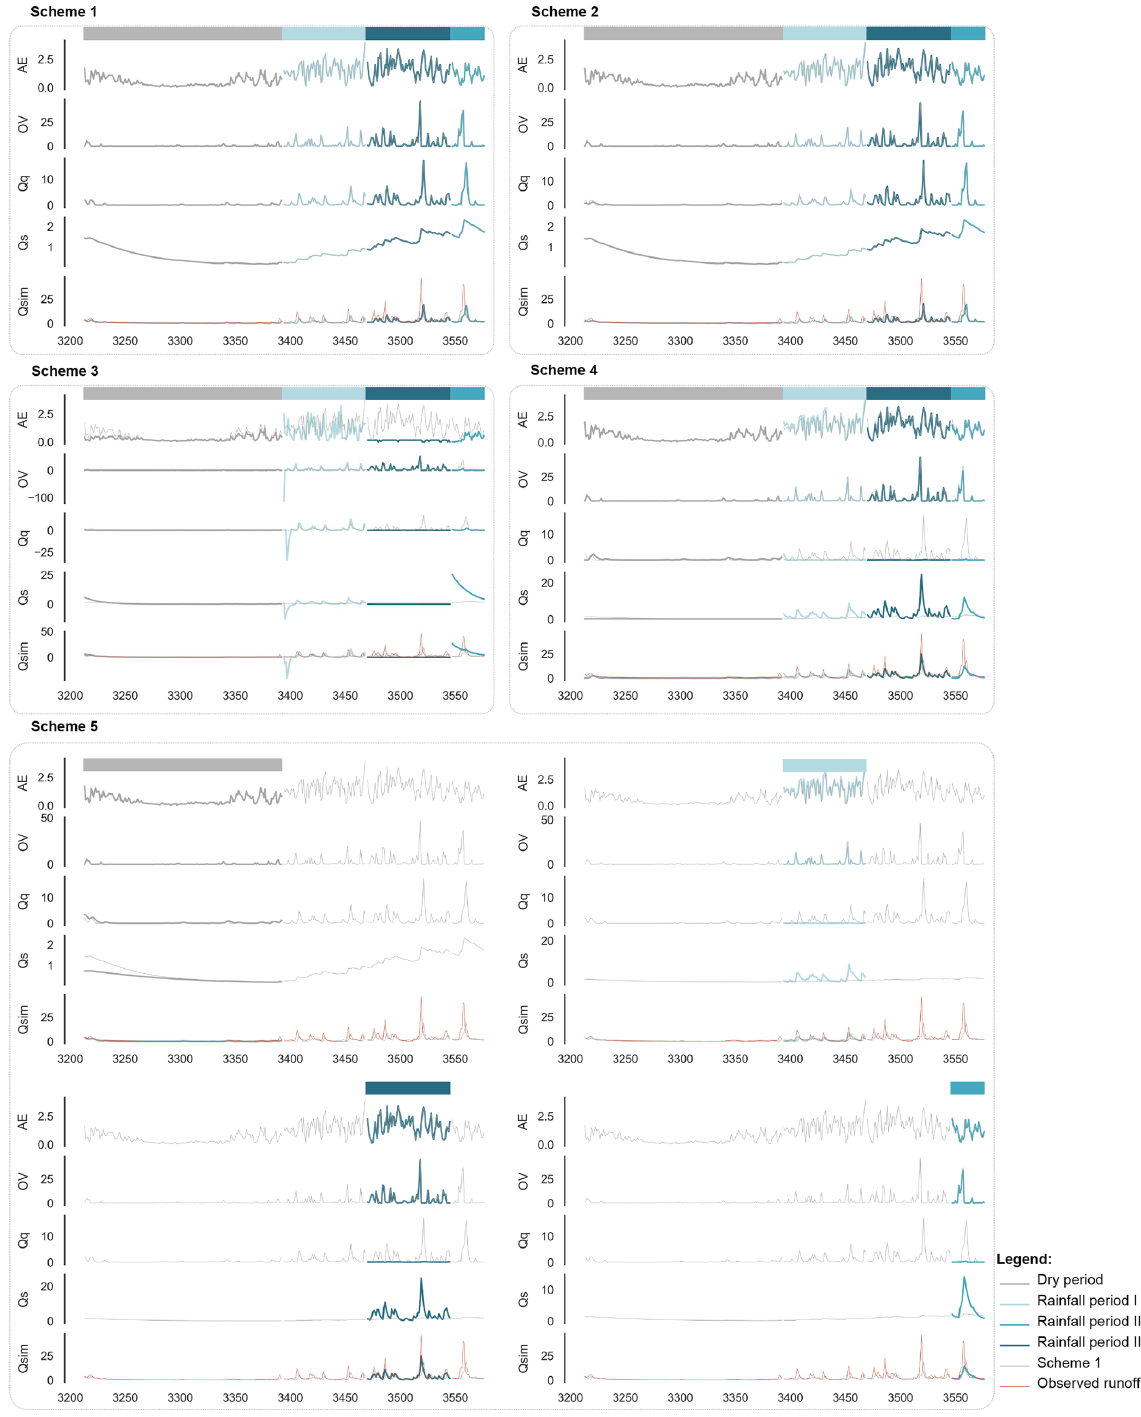
Figure 4. Results of the flux assessment. The fluxes (including AE, OV, Q q , Q s and Q sim ) for the five schemes in the reference year in the validation period in the Hanzhong basin. Note that the variables in different sub-periods are denoted by different colors (same colors as in Fig. 2a). The variables of scheme 0 are denoted by the thin grey lines in each box. The observed streamflow time series data are denoted as thin red lines. All fluxes and state variables in the calibration and validation periods are presented in Sect.